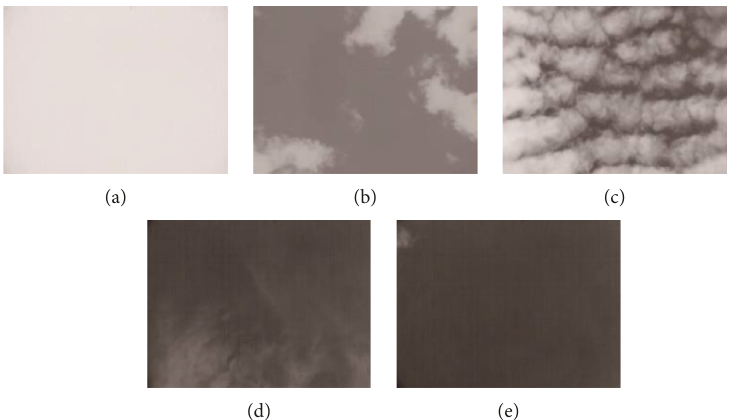
Figure 1: Sample images from the zenithal dataset. (a) Stratiform clouds. (b) Cumuliform clouds. (c) Waveform clouds. (d) Cirriform clouds. (e) Clear sky.